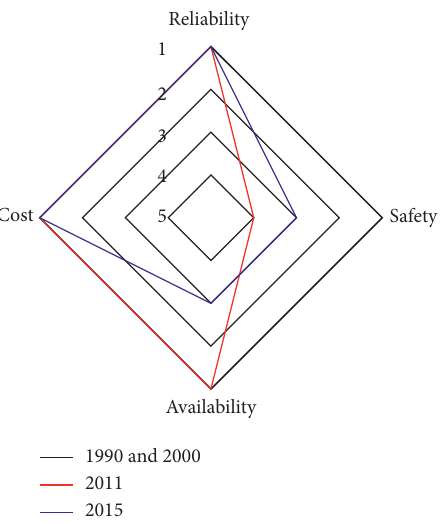
Figure 7: Bridge condition evolution until the last year of inspection.